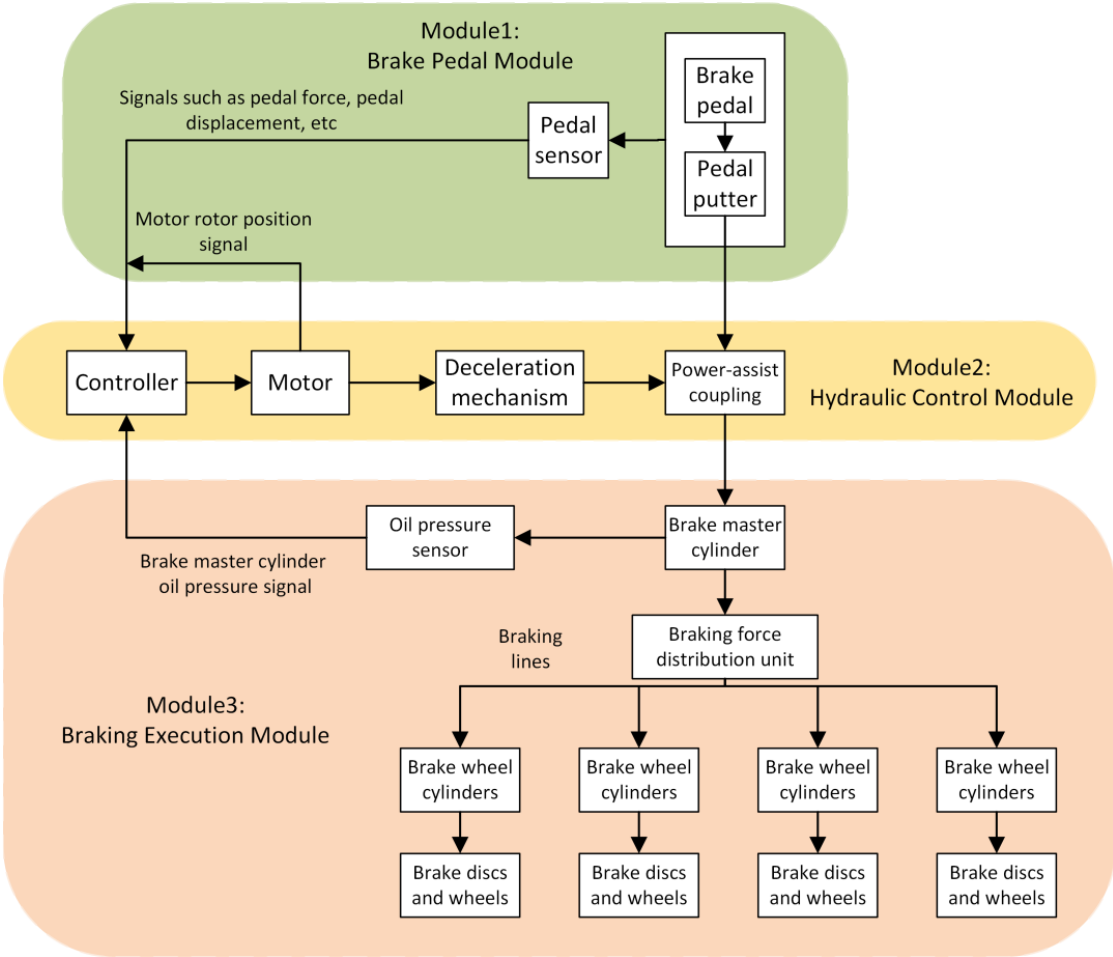
Figure 1. The electronically assisted brake system structure.